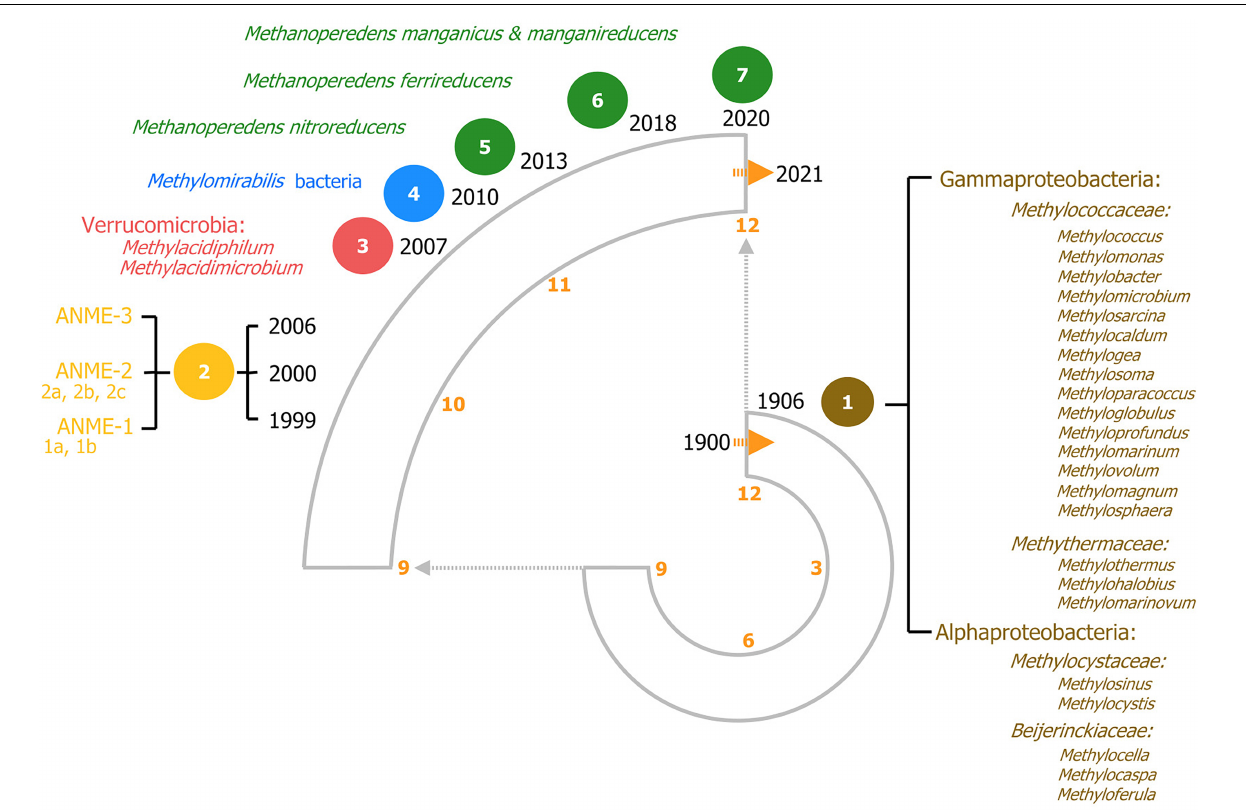
FIGURE 2 | 120 years of methanotrophy depicted in a clock-based timeline, each hour on the clock represents one decade. The most relevant findings are depicted highlighting all recognized methanotrophic groups categorized according to their phylogenetic classification. Seven major milestones in methanotrophy are included, representing the most noteworthy microbial discoveries. (1) In brown, the discovery of aerobic canonical methanotrophy in 1906. On the right, all the known genera according to phylogenetic classification are listed (based on Dedysh and Knief, 2018). (2) In yellow, the discovery of sulfate-dependent anaerobic oxidation of methane (S-dAOM). This process is performed by three defined groups of AN-aerobic ME-thanotrophic archaea (ANME) within the Euryarchaeota phylum. (3) In red, aerobic methanotrophy within the Verrucomicrobia phylum. (4) In blue, nitrate-dependent anaerobic oxidation of methane (N-dAOM) by Methylomirabilis